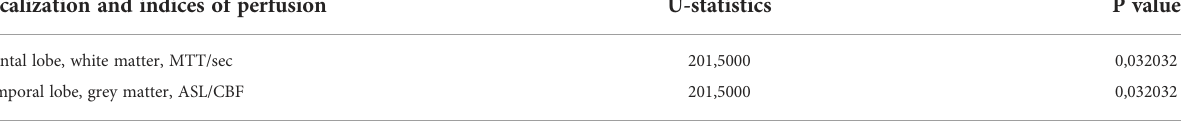
TABLE 4 Asymmetry of neurovascularization according to contrast and non-contrast perfusion in patients with type 1 diabetes mellitus and cognitive impairment. Localization and indices of